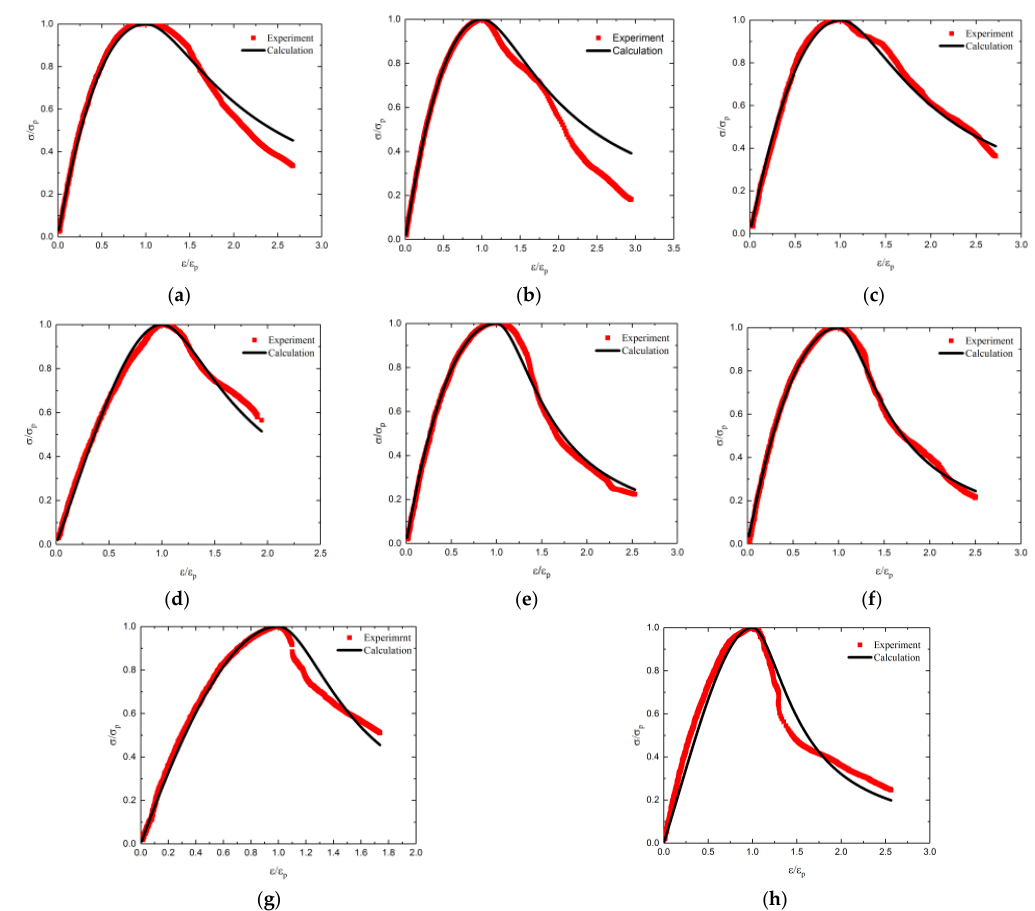
Figure 13. The comparison between the calculated and experimental stress–strain curves for RC40 and RC100: ( a ) RC40-1, ( b ) RC40-2, ( c ) RC40-3, ( d ) RC40-4, ( e ) RC100-1, ( f ) RC100-2, ( g ) RC100-3 and ( h ) RC100-4.